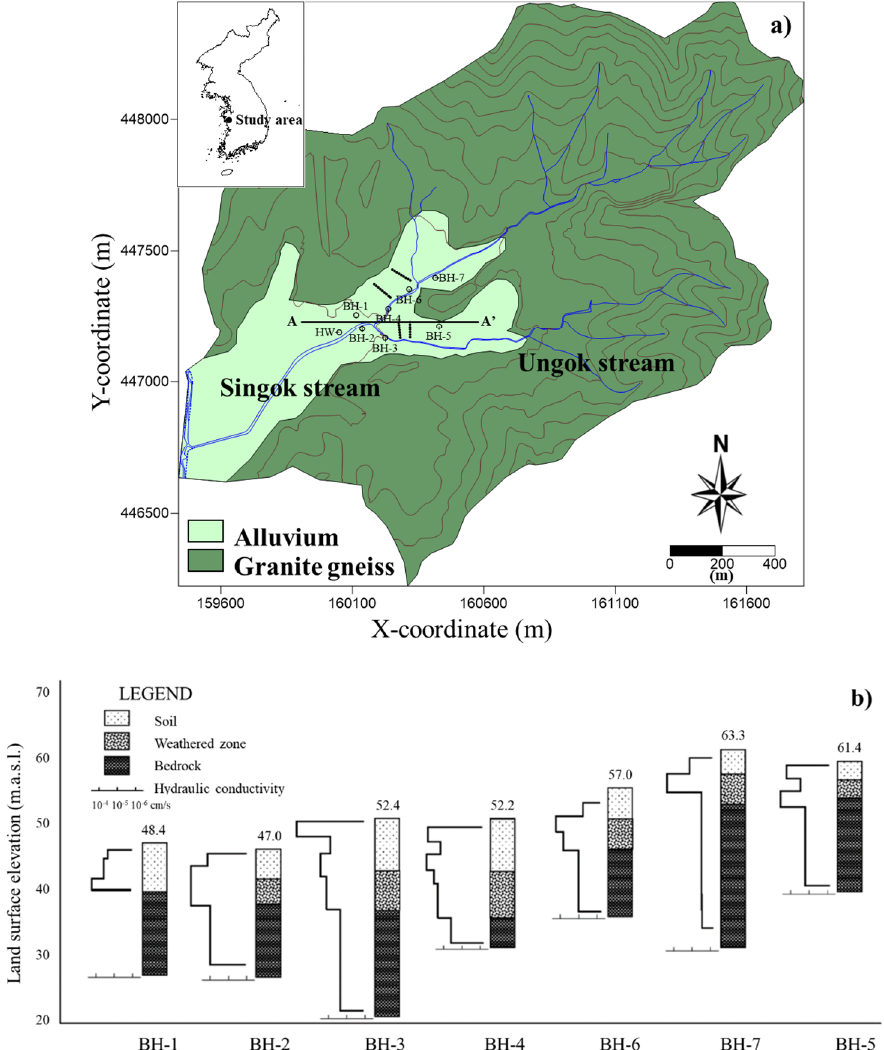
Figure 1. ( a ) Location of the study area and ( b ) geologic cross section along A–A’